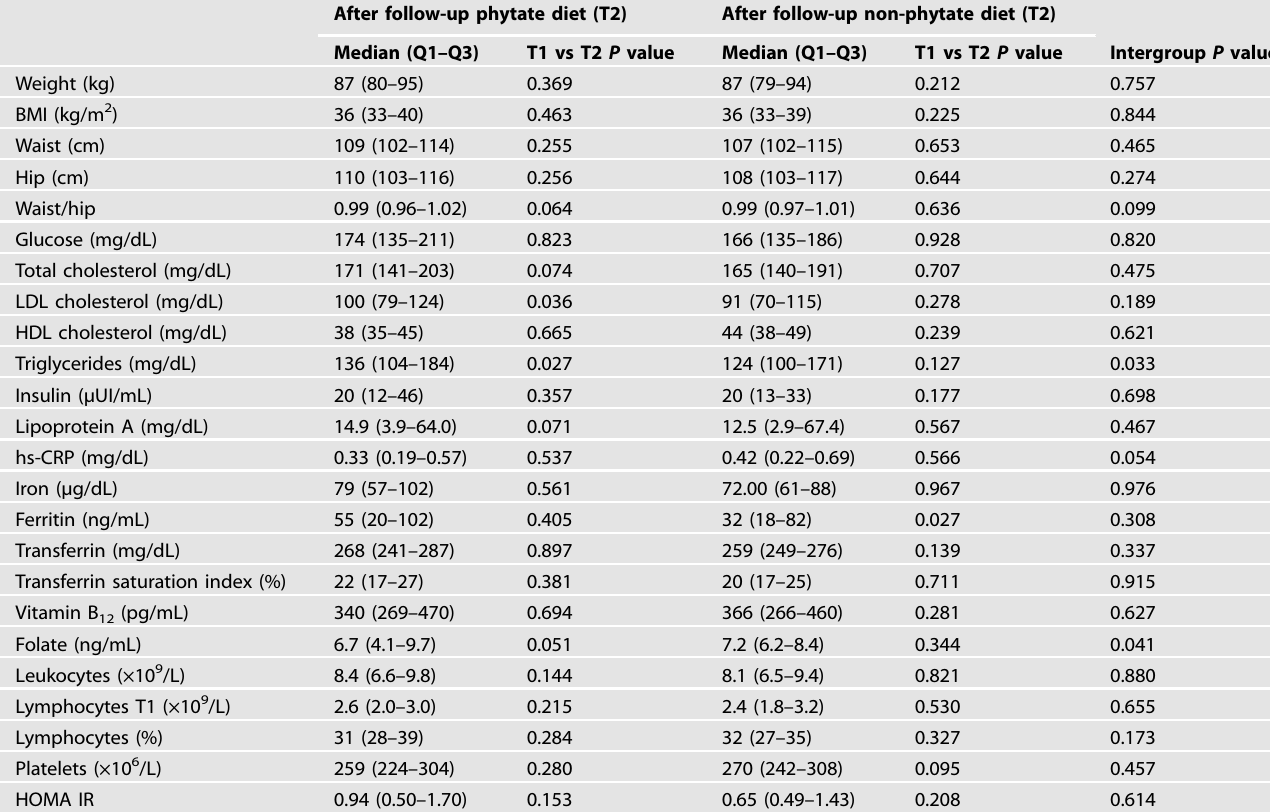
Table 4. Changes in vascular risk factor after follow-up period (6 months).